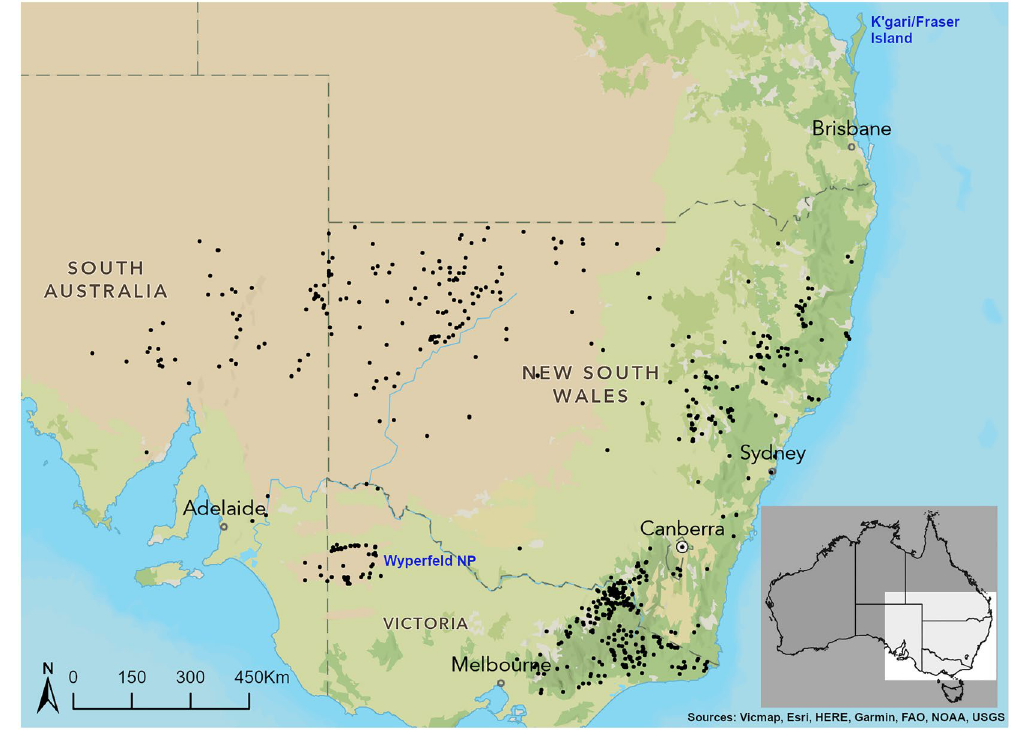
Figure 4. Locations of 1138 samples (black dots) taken from controlled free-ranging dogs. Capital city names are in lower case black text, state names are in capitals. The Wyperfeld/ Big Desert Wild Dog Management Zone and adjacent South Australian capture area (Western Victoria, n = 59) is noted in blue text, as is K’gari/Fraser Island which contains a comparable population. Dingoes and other free-ranging dogs are largely absent from the blank areas of New South Wales, Victoria and South Australia, but they are present and unsampled in the blank areas surrounding Canberra and coastal north-eastern and south-eastern NSW. Dashed lines show state borders, inset map shows the extent of the map within Australia in light area. Map was created using ArcGIS Pro v2.9.3 with terrain from “Outdoor” [basemap] Scale Not Given. June 16, 2022. https:// www. arcgis. com/ apps/ mapvi ewer/ index. html? webmap= 2e8a3 ccdfd 6d42a 995b7 9812b 3b0eb c6 (accessed July 19,